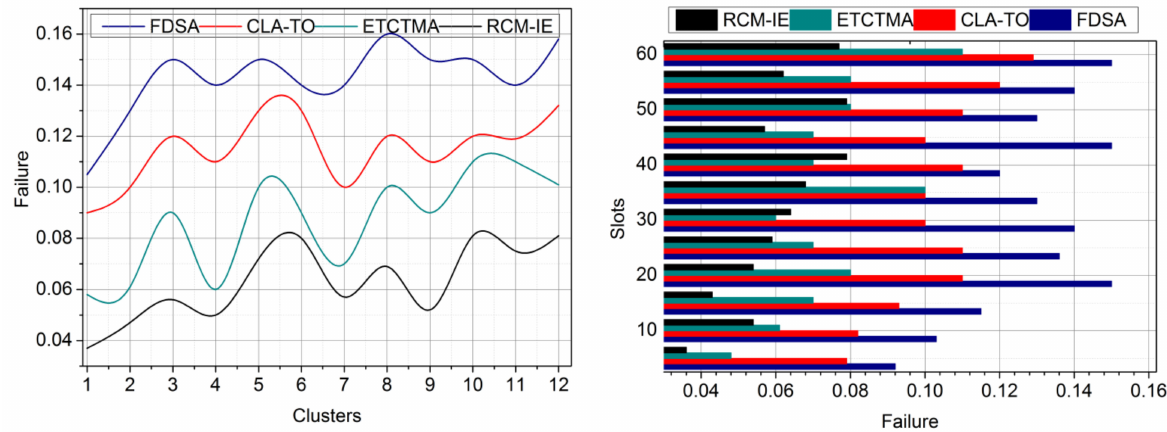
Figure 12. Failure